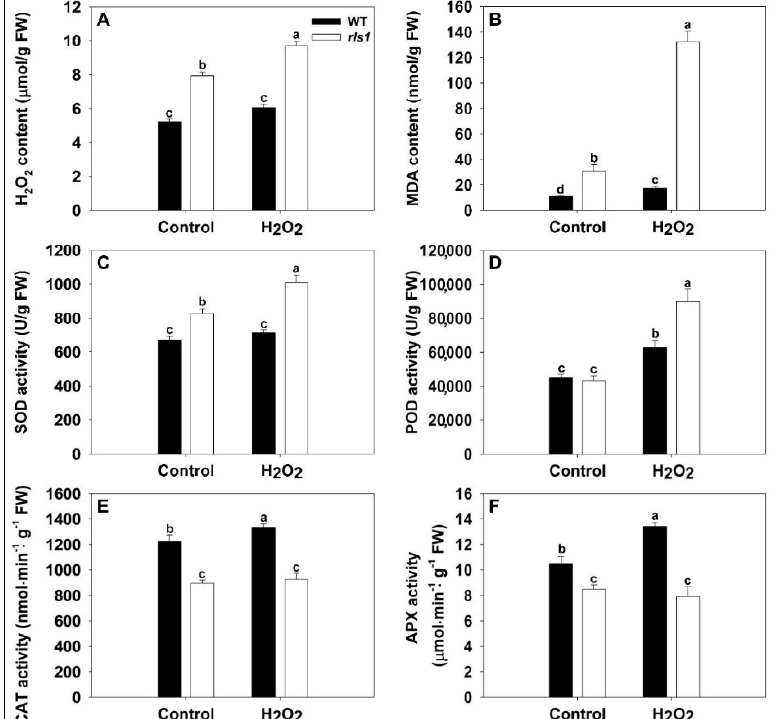
Figure 7. The biochemical response of WT and rls1 plants to exposure to oxidative stress. The content in the leaf of ( A ) H 2 O 2 ; ( B ) MDA; ( C – F ) the activity of the anti-oxidant enzymes ( C ) SOD